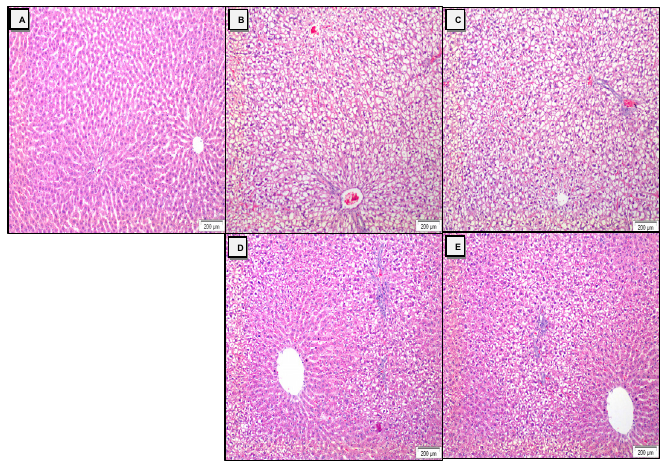
FIGURE 2 - Microphotographs of normal liver tissue (A) and animals fasted for 48 hours and refed with high-fructose diet for 24 hours (B and C) and 48 h (D and E). H & E, 10x